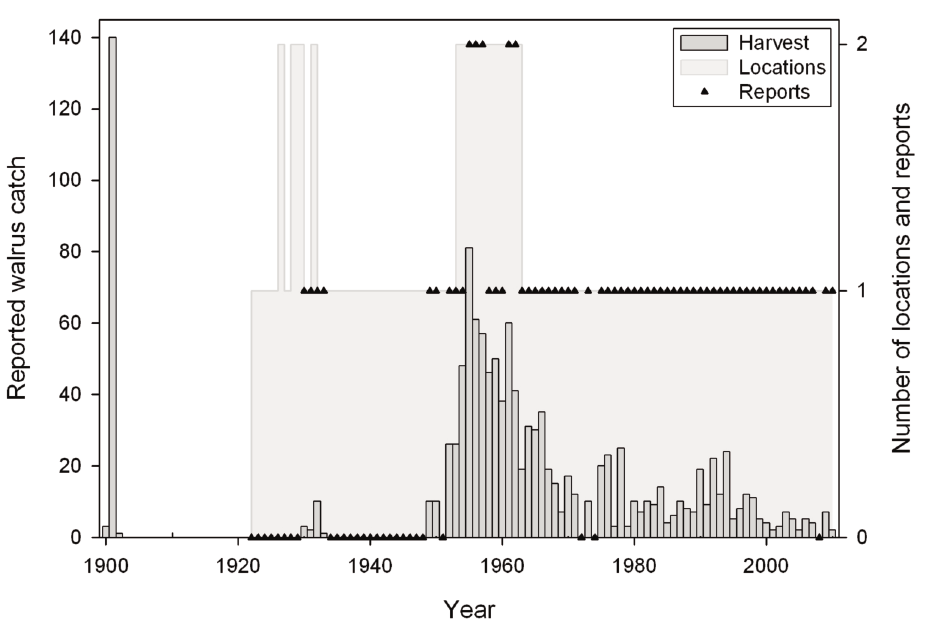
Fig. 14. Catches by Inuit and shore-based traders, and community reporting rates, from the Western Jones Sound–Baffin Bay (WJS-BB) area of the Canadian High Arctic walrus popula- tion, 1900–2010.